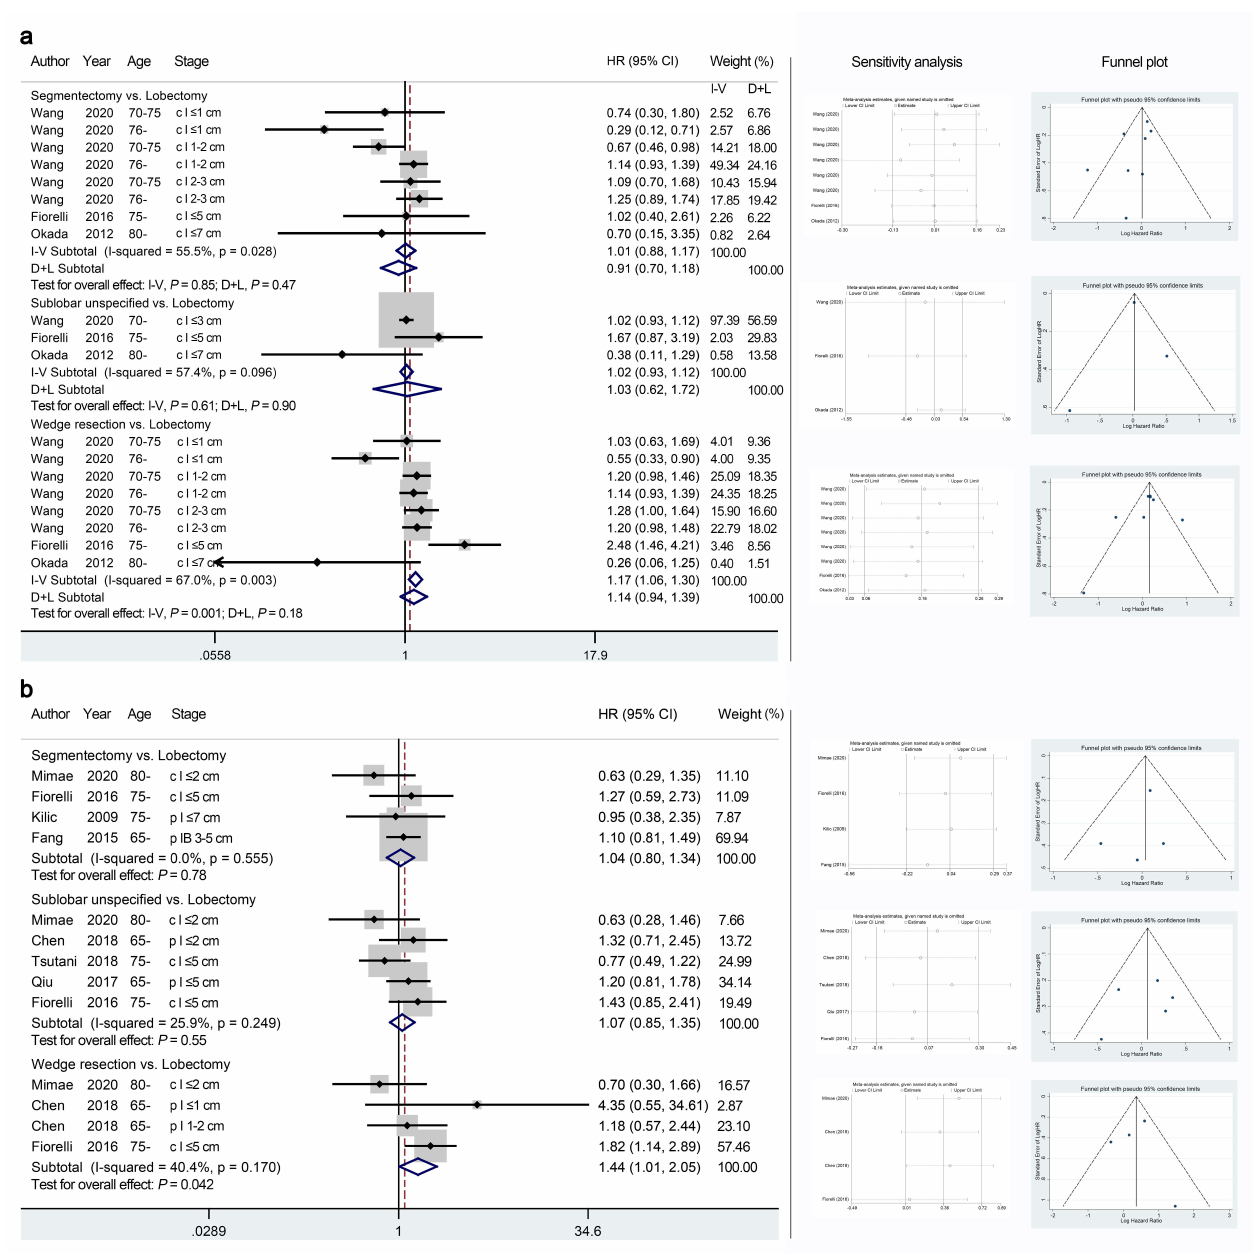
Figure 3. Meta-analyses comparing the cancer-specific survival ( a ) and disease-free survival ( b ) outcomes of sublobar resections with those of lobectomy. The right panel presents the outcomes of sensitivity analyses and the funnel plots corresponding to the forest plots shown in the left panel. HR, hazard ratio; CI, confidence interval. I-V: fixed-effects model; D+L: random-effects